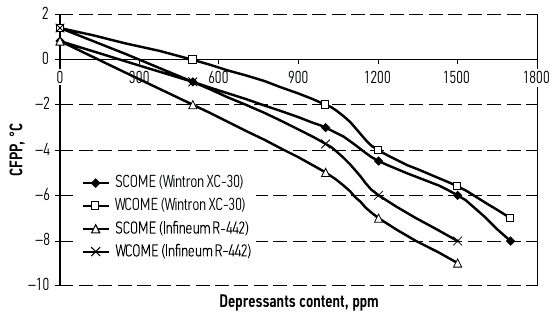
Fig. 5. The dependence of depressant concentration on the CFPP of fuel mixtures containing fatty acid methyl esters of Camelina sativa oil and used for frying oil (SCOME and